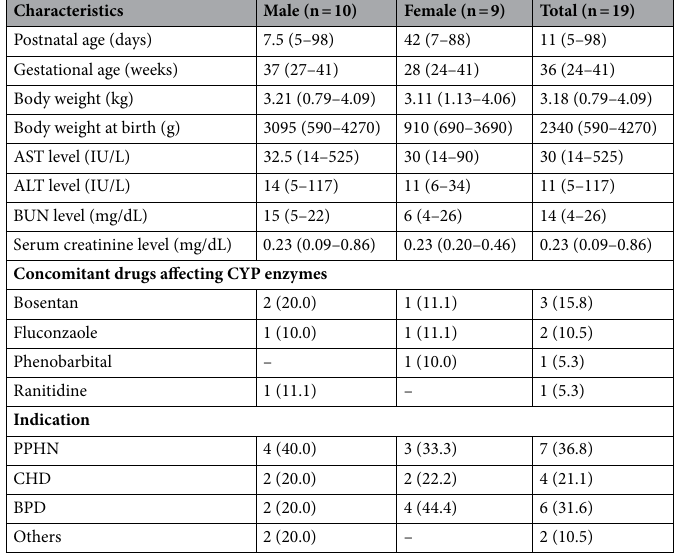
Table 1. Clinical and demographic characteristics of the study population. Data are presented as the median (range) except for concomitant drugs and indications, which are presented as the number of subjects (percentage, %). AST, aspartate aminotransferase; ALT, alanine aminotransaminase; BUN, blood urea nitrogen; CYP, cytochrome P450; PPHN, persistent pulmonary hypertension of the newborn; CHD, congenital heart disease; and BPD, bronchopulmonary